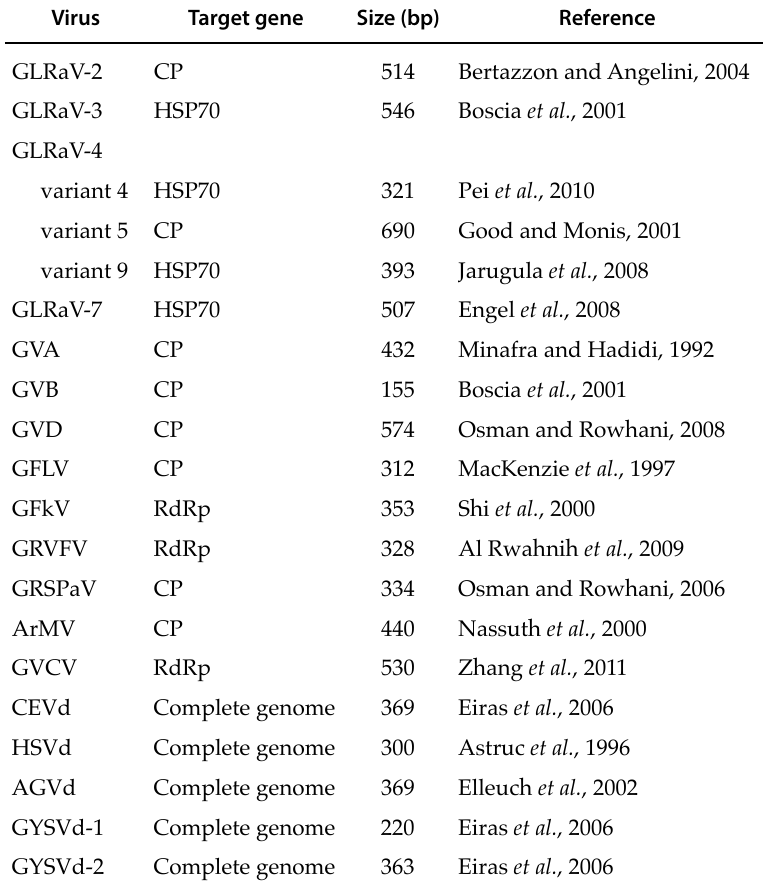
Table 2. Primer pairs used in this